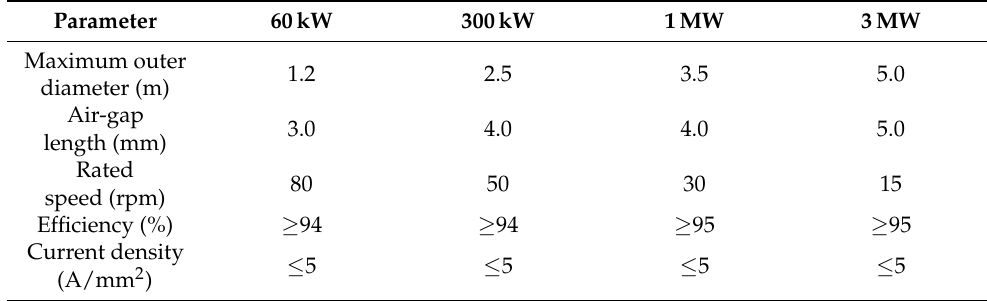
Figure 10. Different active material weight distribution vs. power rating of PMSM (©[2020] IEEE. Reprinted, with permission from [20]). Table 1. Main design specifications of machines at different power levels